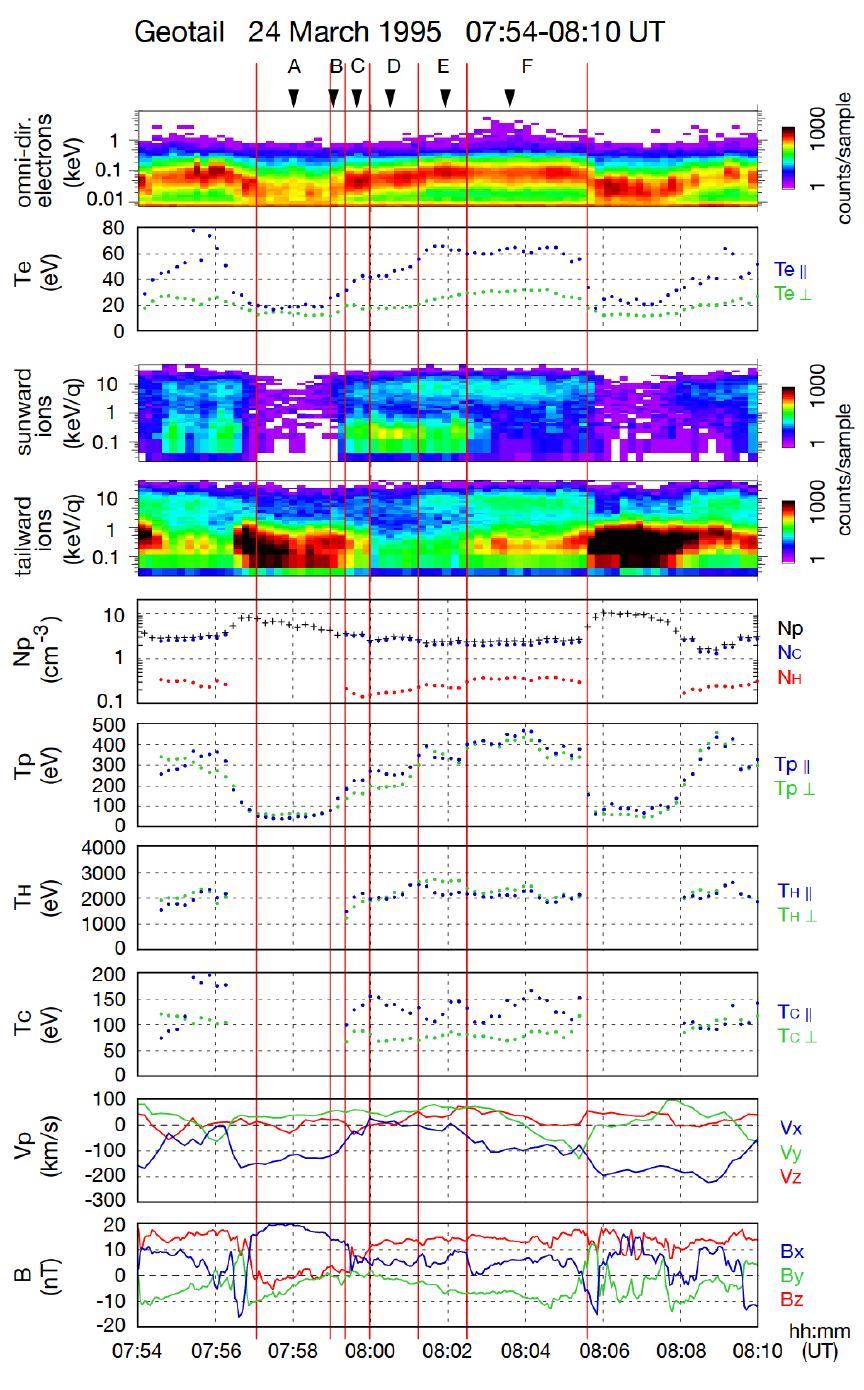
Fig. 4. Expansion of the Geotail observation between 07:54–08:10 UT on 24 March 1995. From the top, E-t spectrogram for electrons, parallel (blue) and perpendicular (green) electron temperatures, E-t spectrograms for sunward and tailward ions, proton density, parallel and perpendicular proton temperatures, temperatures of the hot and cold proton components (for selected intervals), three components of the bulk proton flow, and the magnetic field are shown. Time resolution of plasma data is 12s and that of magnetic field data is 3s. Black triangles at the top of the figure correspond to the data whose cuts of the velocity distribution functions are shown in Figs. 5, 7, and